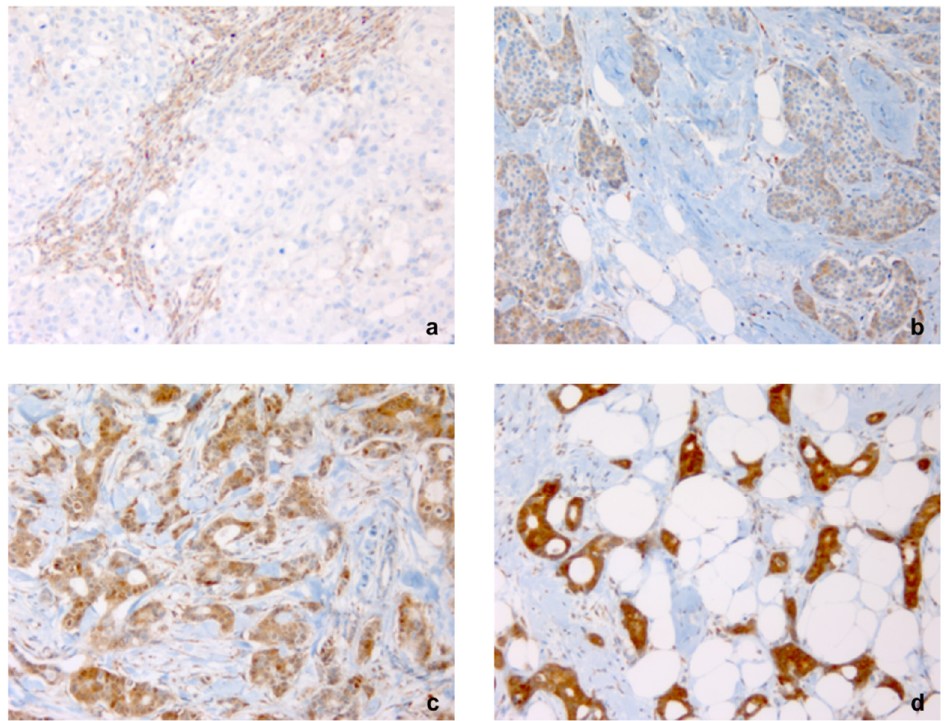
Figure 1. Intensity of immunostaining for FGD3 in breast cancer tissue blocks. Note: Staining was ( a ) negative ( − ) with positive control in inflammatory cells, ( b ) low (+), ( c ) moderate (++), ( d ) intense (+++) ( × 200).